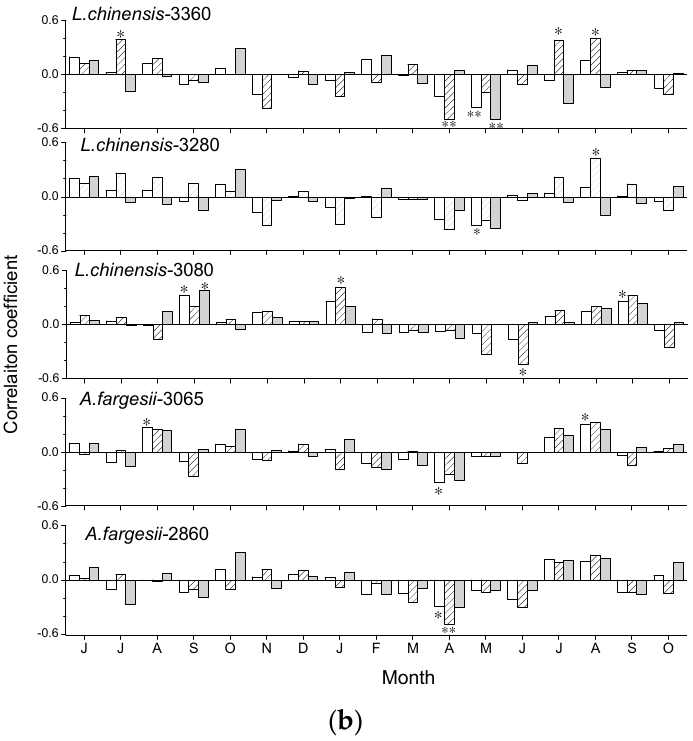
Figure 5. Correlations (* p < 0.05, ** p < 0.01) obtained by relating the standard tree-ring width chronologies of Larix chinensis and Abies fargesii with monthly mean temperature ( a ) and precipitation ( b ) along the site elevations. Climate variables go from the June of the previous year to current October of the year of tree-ring formation. Empty bars, hatched bars, and solid grey bars correspond to the 1960–2015, 1960–1987, and 1988–2015 periods, respectively.